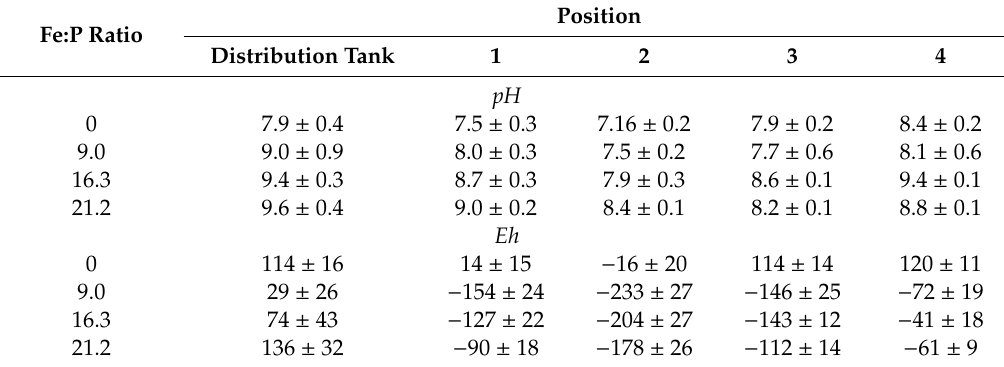
Table 1. Summary of pH and Eh (mV) measurements in tanks at each position of the treatment-train. Fe:P Ratio